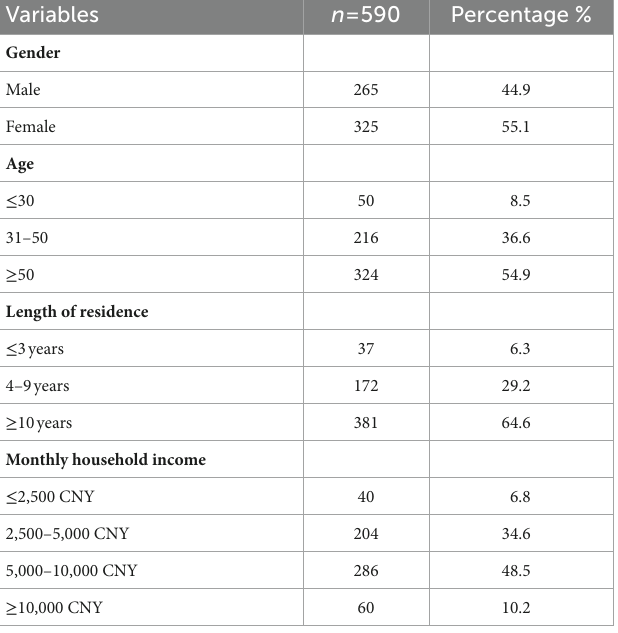
TABLE 1 Characteristics of the